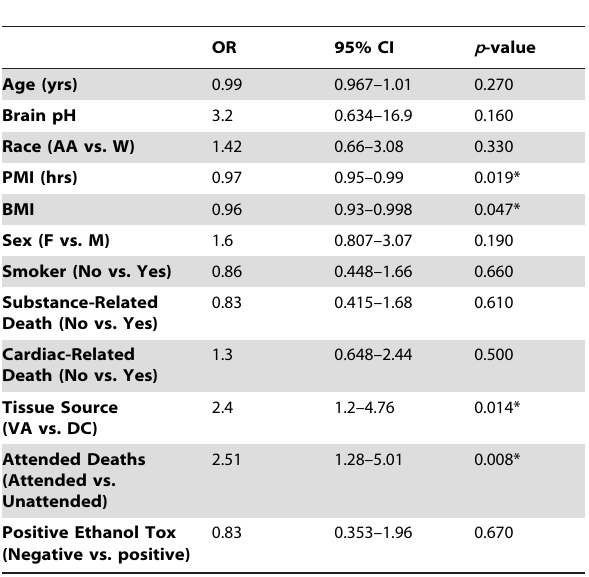
Table 2. Demographic and sample parameters of successful culture in scalp